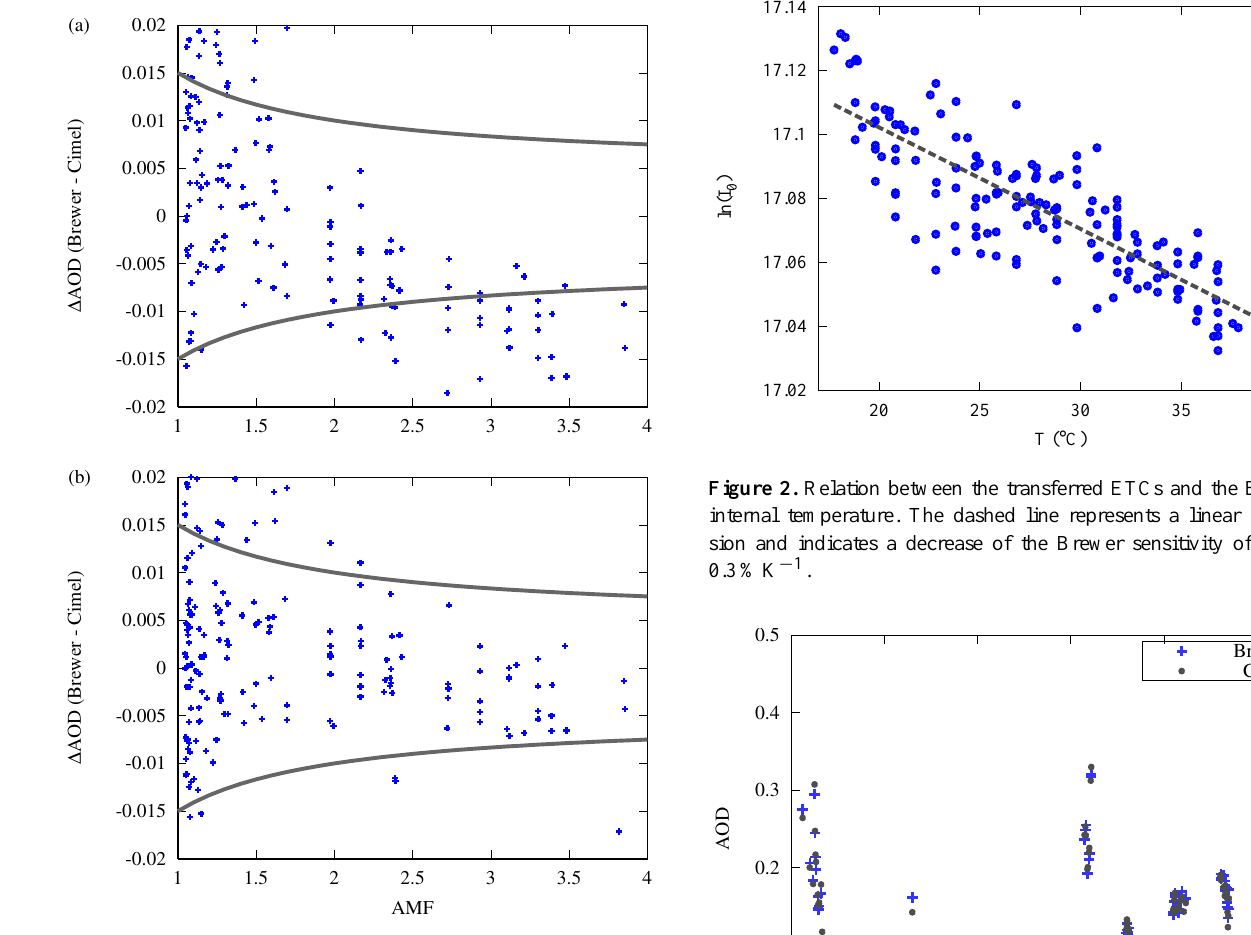
Figure 1. Differences of AODs measured at 437nm by both instru- ments as a function of the air mass during the campaign period. The curved lines represent the acceptance limits fixed by WMO (2004). The upper figure is obtained without correcting for the Brewer tem- perature, whereas the lower shows the temperature-compensated re- sults as explained in Sect. 4.1.